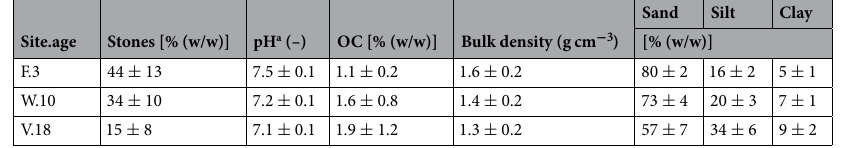
Table 1. Soil properties of SIS. They are calculated as the mean of all depth steps of four soil cores ± standard deviation. Since the number of depth steps differed between the sites and the number of laboratory repetitions differed, the number of repetitions varied among the methods and the sites (pH: n = 51 –69, OC: n = 17 –23, Stones: n = 16 –22, Bulk density: n = 16 –22; for details see Table S4). a pH in 0.01 M CaCl 2 .